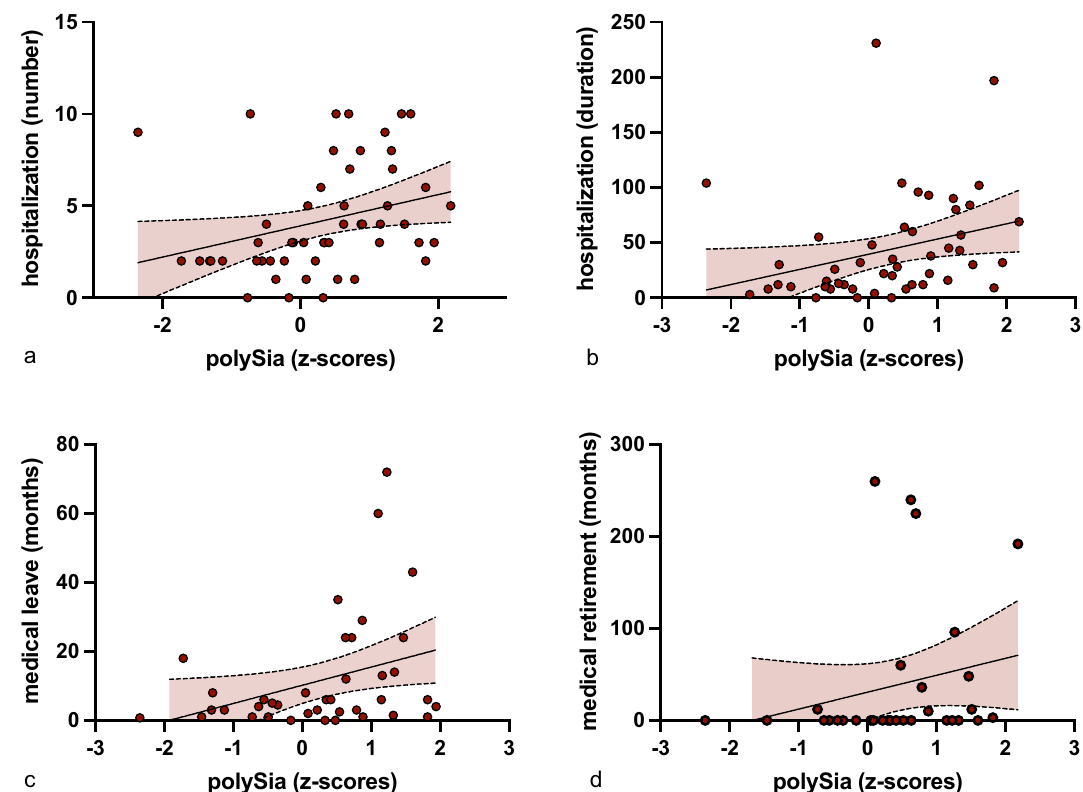
Figure 3. PolySia serum levels correlate with longterm disease trajectories. Correlation of polySia serum levels in SZ/SZA patients with ( a ) the number of hospitalization ( p = < .001)) ( b ) and duration of hospitalizations in months ( p < .001), ( c ) medical leave ( p = .012) and ( d ) early retirement due to medical reasons ( p =